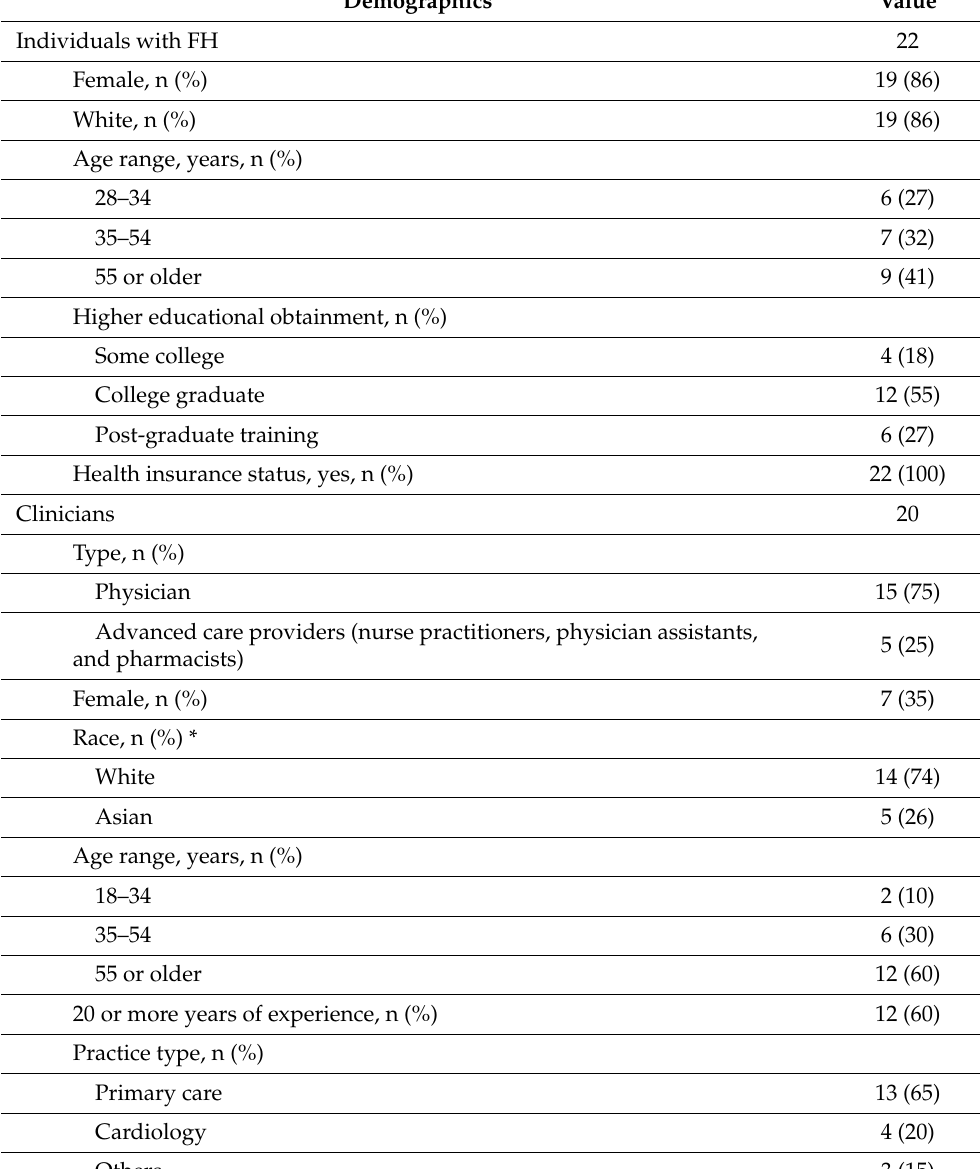
Table 2. Demographics of individuals with FH and